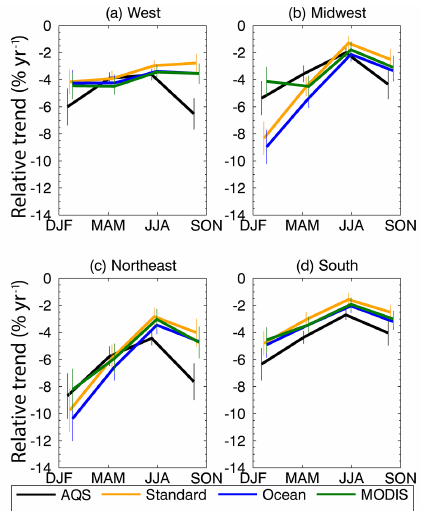
Figure 4. Seasonal relative trends of NO 2 calculated from the AQS in situ measurements (“AQS”, black line) and those derived from different OMI VCD data (“standard”, orange line; “ocean”, blue line; “MODIS”, green line). The error bars represent 95th-percentile confidence